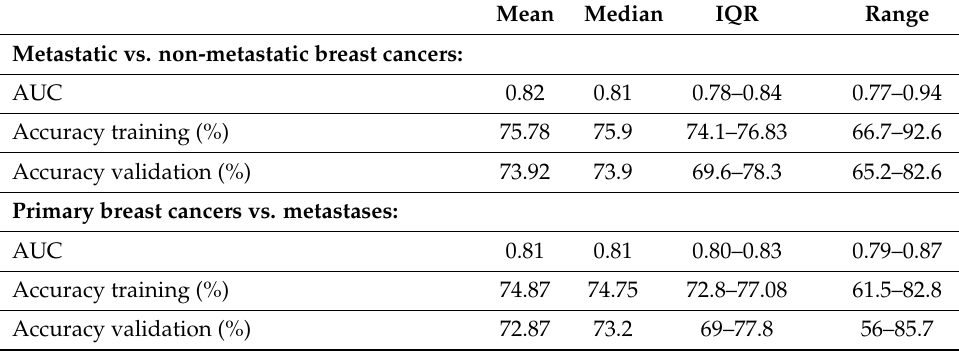
Table 1. Classification AUCs and accuracies for radiomics data.